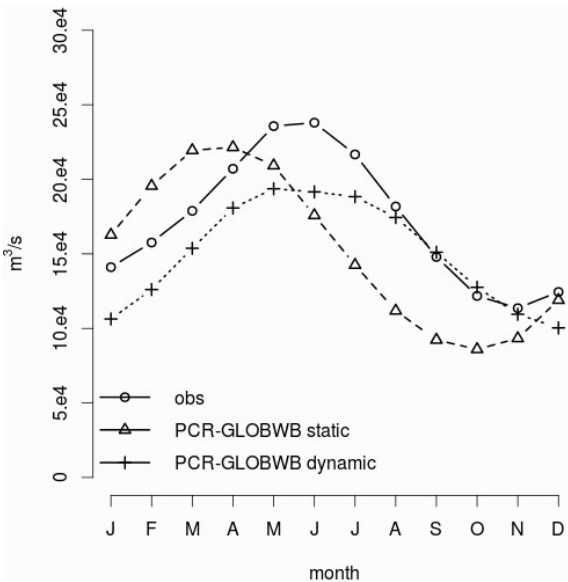
Fig. A5. Hydrograph at Obidos: comparison between observations (circles) and PCR-GLOBWB simulations (triangles and crosses). This figure shows the improvement in simulated seasonality when dynamic in floodplain extent is accounted for in PCR-GLOBWB (crosses, this study) against static floodplain area (triangles, Van Beek et al., 2011).